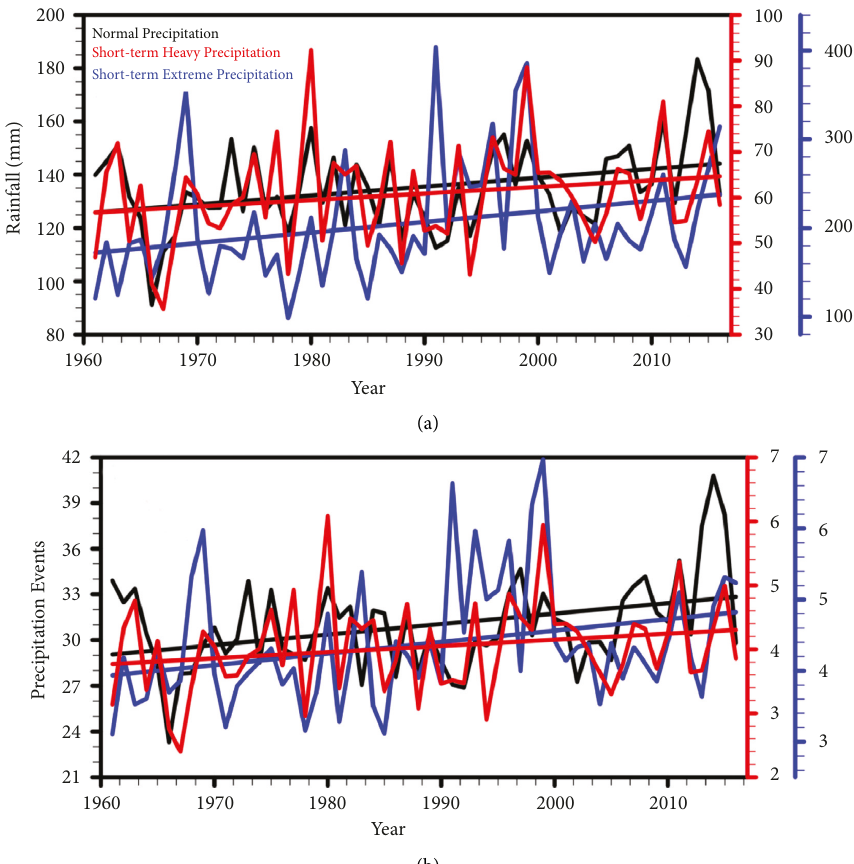
Figure 3: The time-series data of the (a) amount of precipitation and (b) number of precipitation events during the summers of